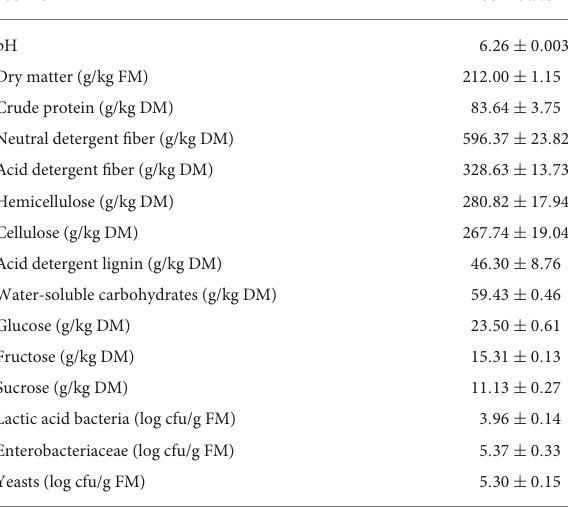
TABLE 1 Chemical composition and microbial counts of the oats before